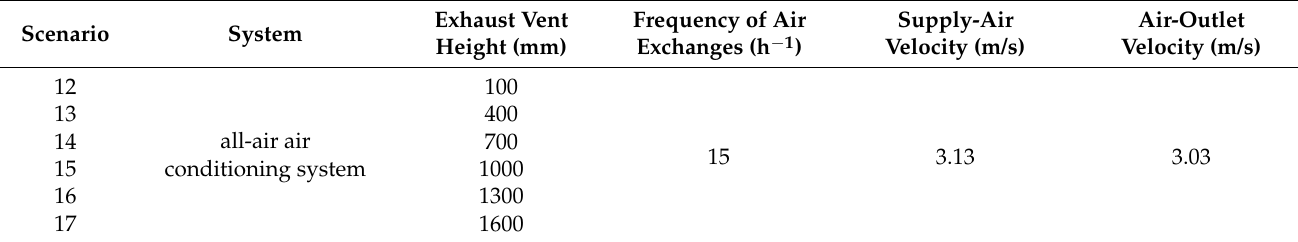
Table 11. Boundary conditions for exhaust vent height.